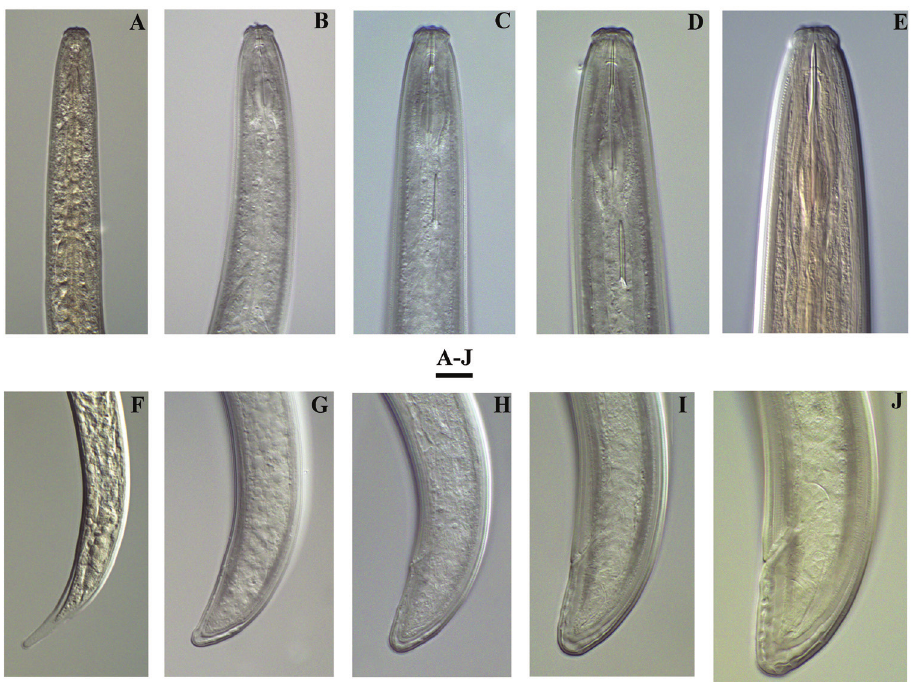
Figure 6. Enchodeloides signyensis (Loof, 1975), gen. n., comb. n. (= Enchodelus signyensis Loof, 1975). Juveniles (specimens from Livingston Island): A–D Anterior ends (J1-J4) F–I Tail ends (J1-J4) Female (specimen from Livingston Island) E Anterior end J Tail end . Scale bar: 10